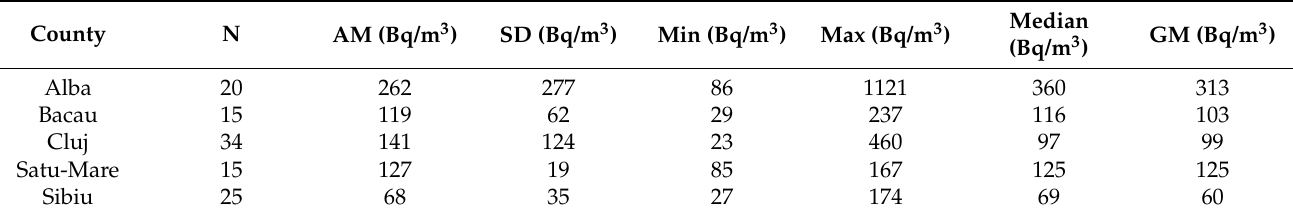
Table 1. Summary statistics of annual radon concentration in schools and kindergartens.